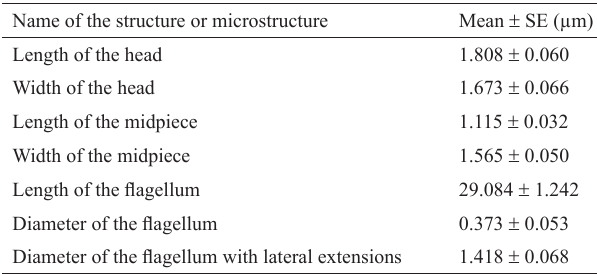
Table 1. Measurements of the different parts of pejerrey spermatozoa (length, width and diameter)